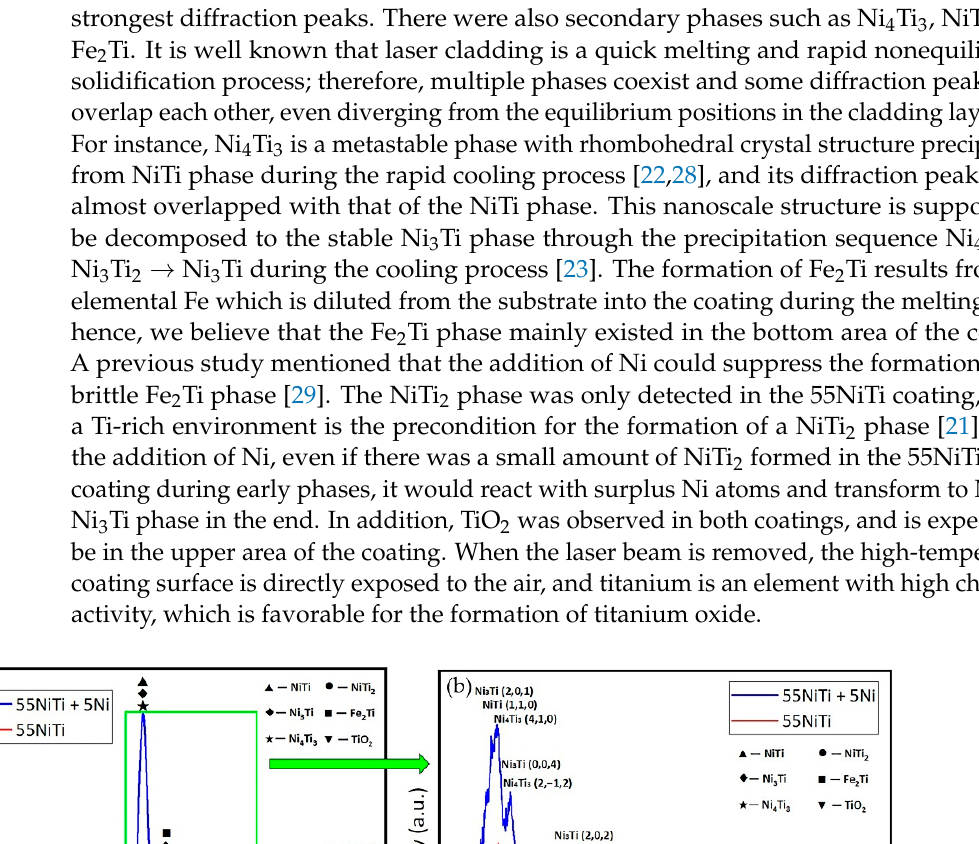
Figure 6. XRD results of the coatings: ( a ) overview of the patterns; ( b ) magnification of the patterns between 40° and 60°.